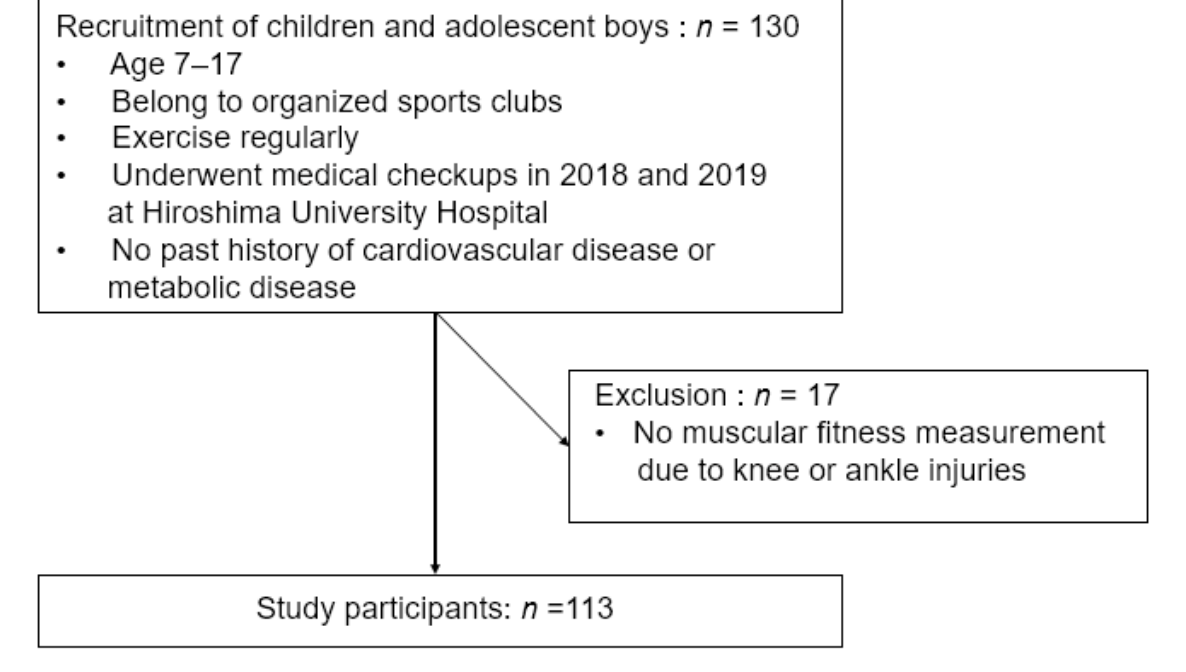
Figure 1. Inclusion and exclusion of participants.